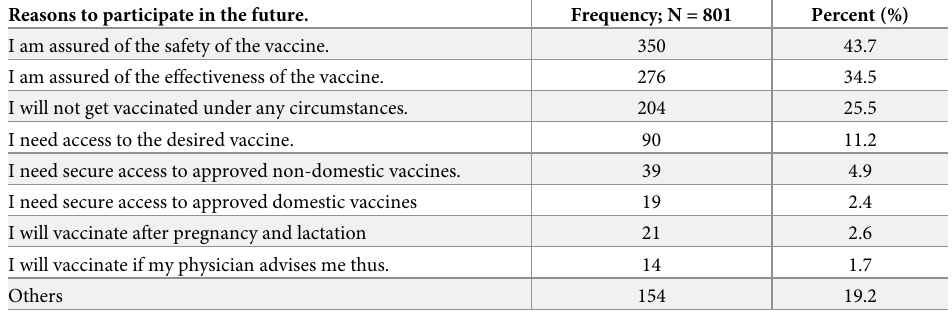
Table 3. Response rate to the question "Under what conditions will you participate in the vaccination program?" among the unvaccinated population in Shiraz, Iran. Reasons to participate in the future.